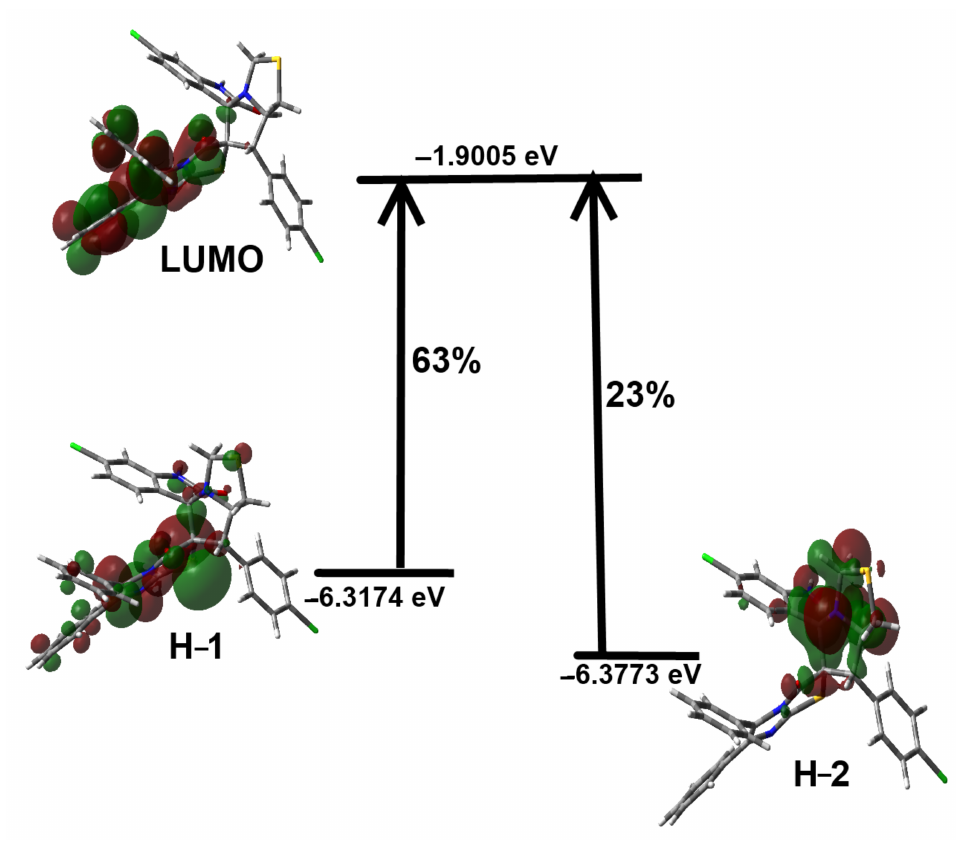
Figure 11. MOs included in the longest wavelength electronic absorption band for the studied system.